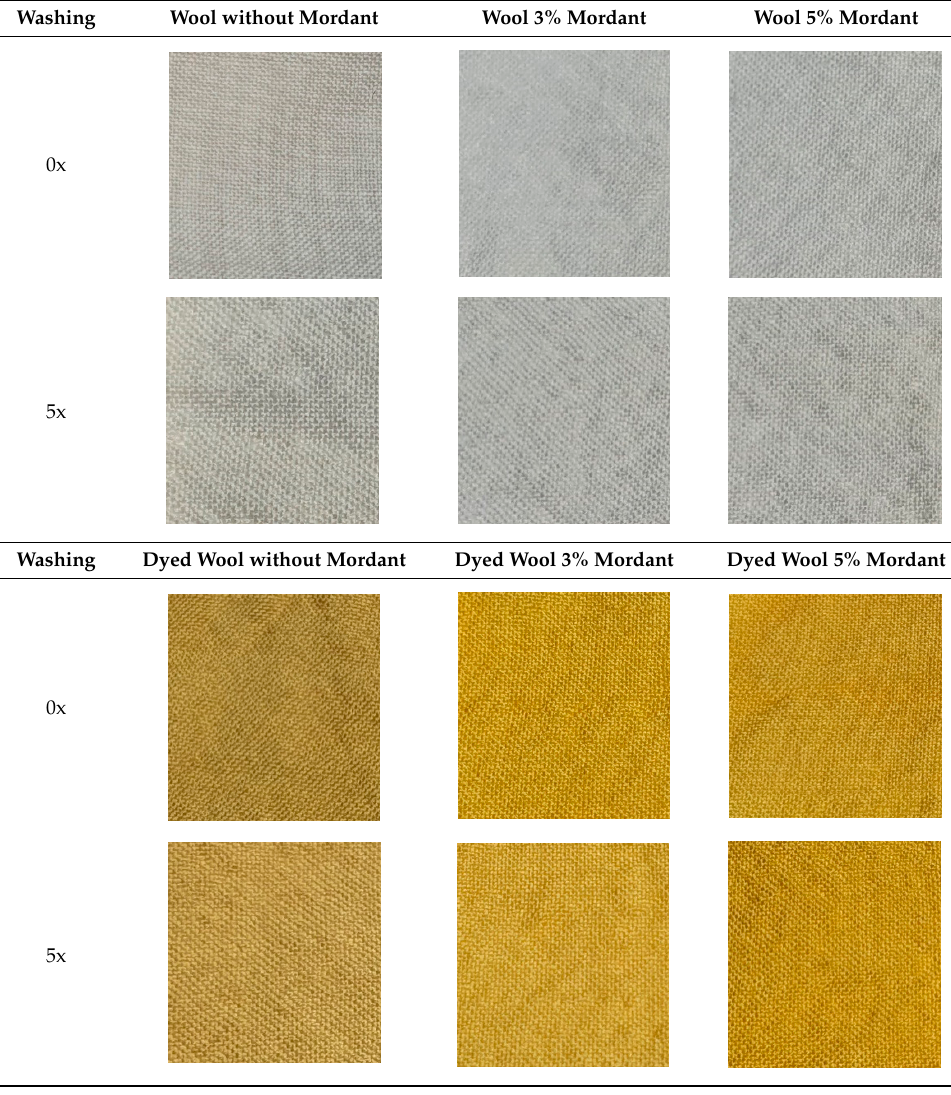
Table 18. Visual assessment of colorfastness to washing.